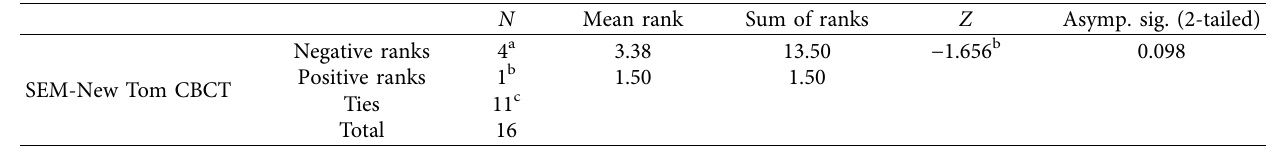
Table 3: Comparison of marginal leakage scores between New Tom CBCT unit and SEM. N